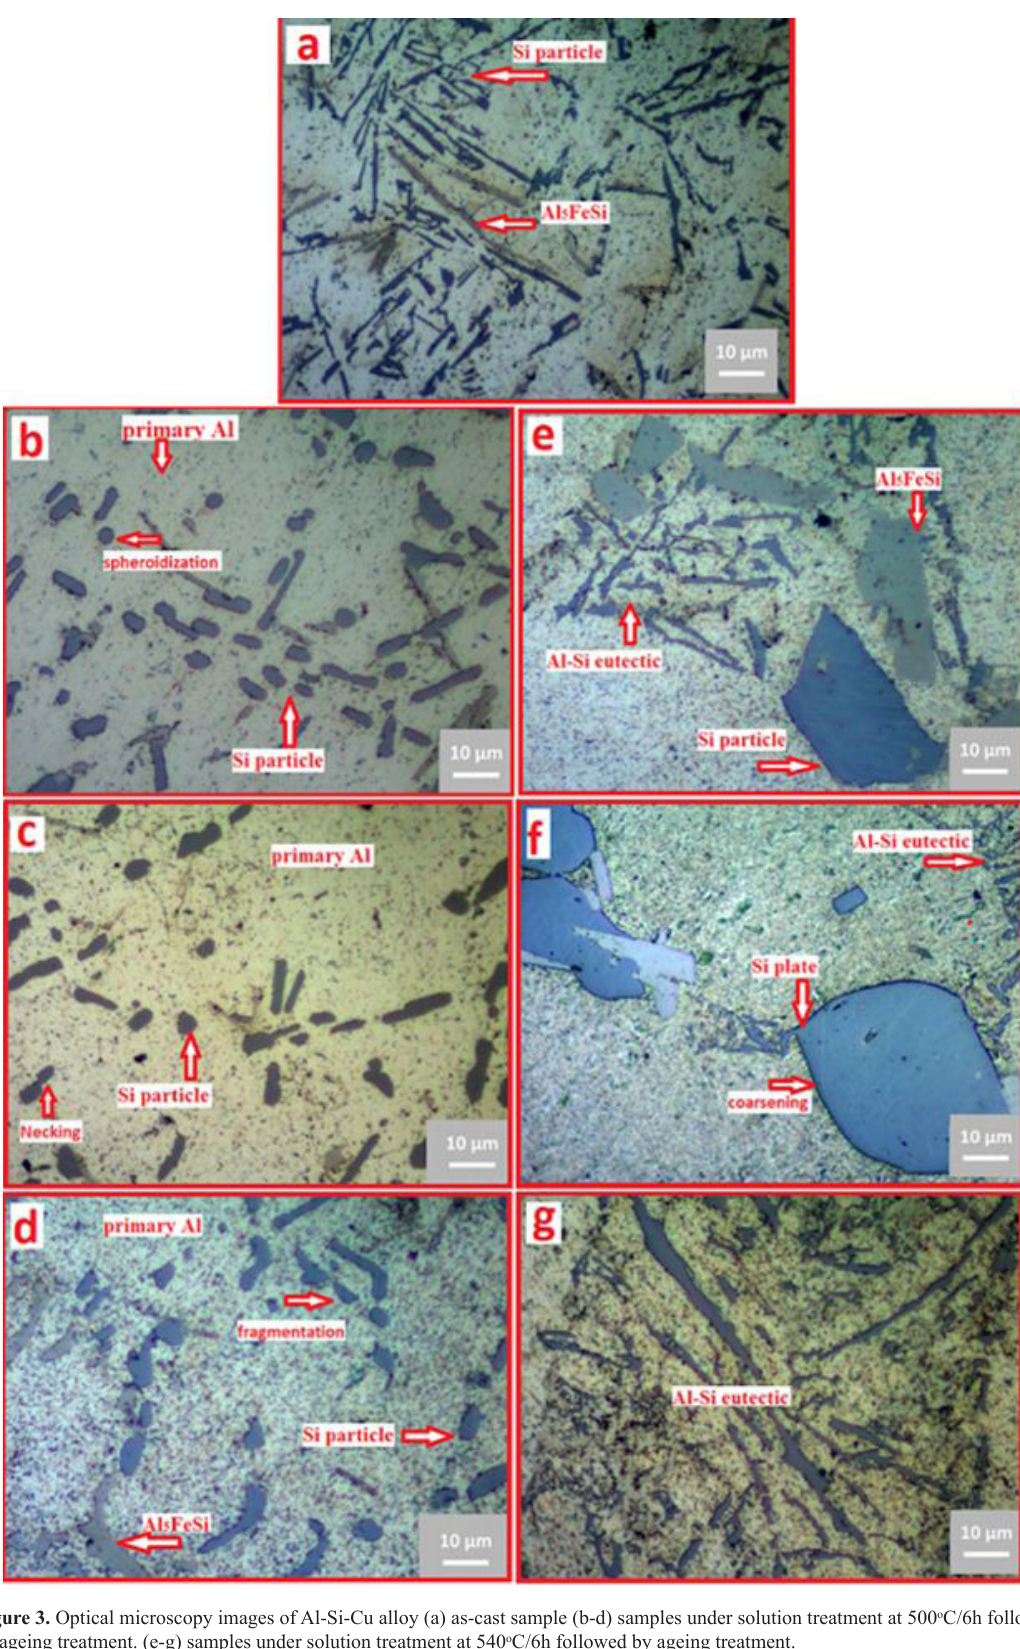
Figure 3. Optical microscopy images of Al-Si-Cu alloy (a) as-cast sample (b-d) samples under solution treatment at 500 o C/6h followed by ageing treatment. (e-g) samples under solution treatment at 540 o C/6h followed by ageing